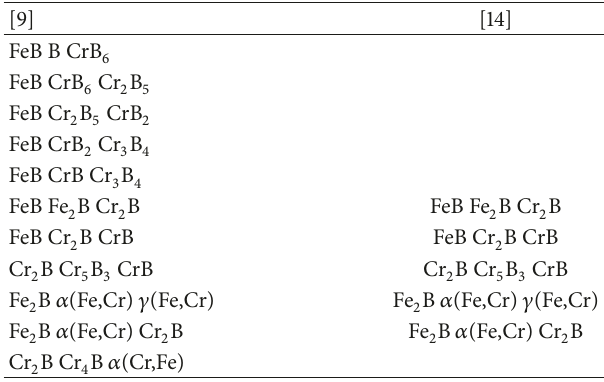
Table 3: Three-phase fields in experimentally determined B-Cr-Fe phase diagram at 1373 K according to the literature [9,